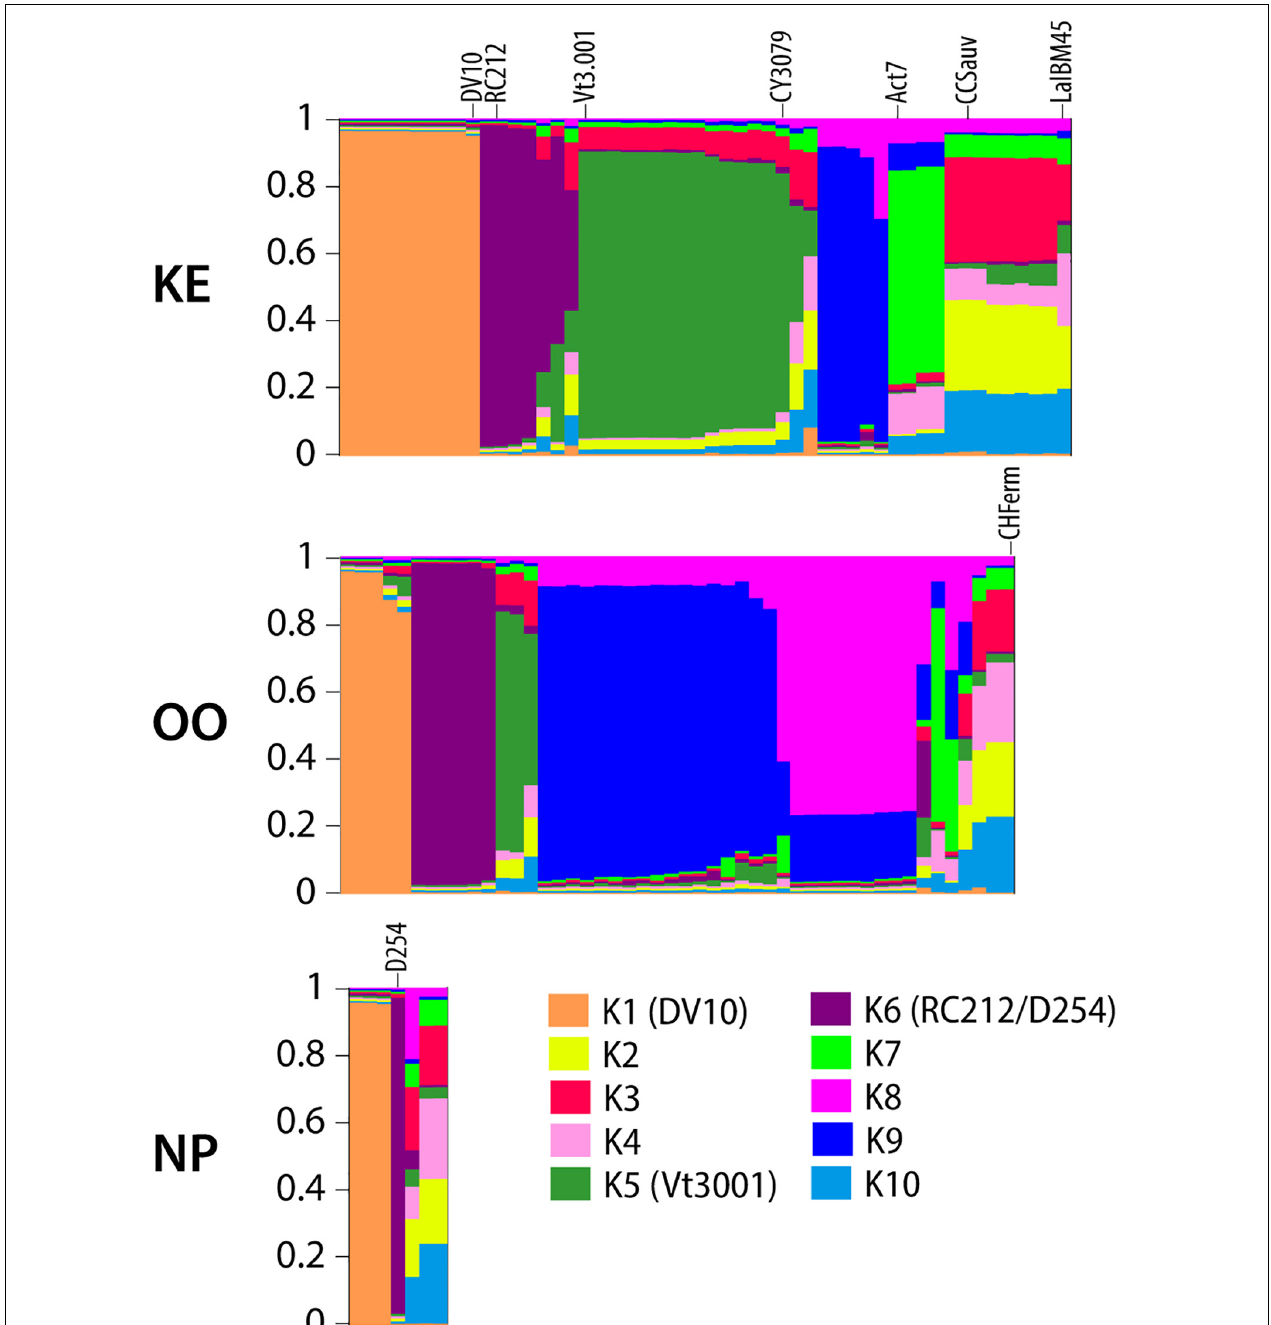
FIGURE 3 | DISTRUCT plots of inferred ancestry profiles of S. cerevisiae strains isolated from KE, OO, and NP sub-regions. Each column represents an ancestry profile for an individual MLG. Each color corresponds to one of ten inferred subpopulations as noted in the legend. The proportion of each color in a column represents the proportion (membership coefficient) of the MLG’s ancestry profile assigned to that subpopulation as measured on the y -axis of each plot. Selected commercial isolate MLG ancestry profiles are labeled on the plot, and subpopulations containing commercial MLGs with membership coefficients > 80% are labeled in the legend with the strain name in